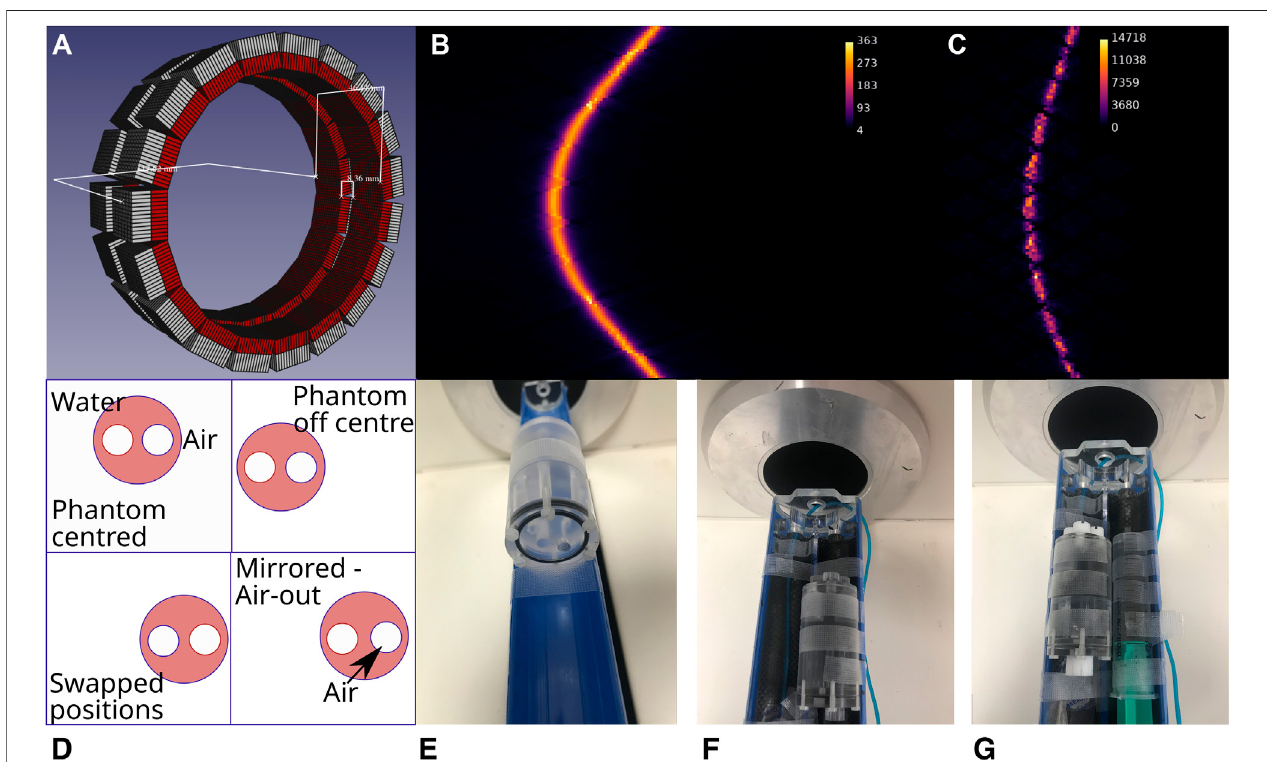
FIGURE 1 | (A) Representation of the geometry of the Sedecal SuperArgus 2R detector geometry. The inner layer of crystals (red) are made of LSO:Ce and the outer layer (gray) are GSO:Ce. (B) Sinogram with corrections, generated by Sedecal ’ s FORE-3D software (size 175 × 128 × 61). (C) Non corrected sinogram created from the .tru fi le containing only counts (size 117 × 117 × 61), as generated in STIR. The two sinograms are from the axial position 29 of the fi rst acquisition 33 MBq. (D) IllustrationofthepositionofNEMA phantominsidetheFOV.Themirrortransformationiswithrespect tothepositionofthecoldcontainers. (E) – (G) photographsof the phantom in the central, off-centre and dual